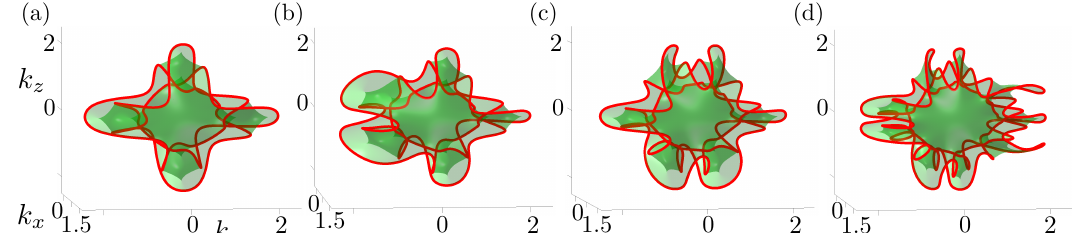
Figure 2: Illustration of more complex hyperbolic exceptional structures, obtained from lattice models defined by Eq. (8), Eq. (12) and Eq. (17) with ε = 1, Λ = 10 4 and n = 4,5,6,9 respectively. Λ is taken to be large in order to smoothen the exceptional structures. These structures resembles the ( 3, n ) Turk’s head links for their respective n , which means that the structures in (a) and (b) are knots, while those in (c) and (d) both are Brunnian links. All this is verified by calculating their respective Alexander polynomials, which are presented in Sec.